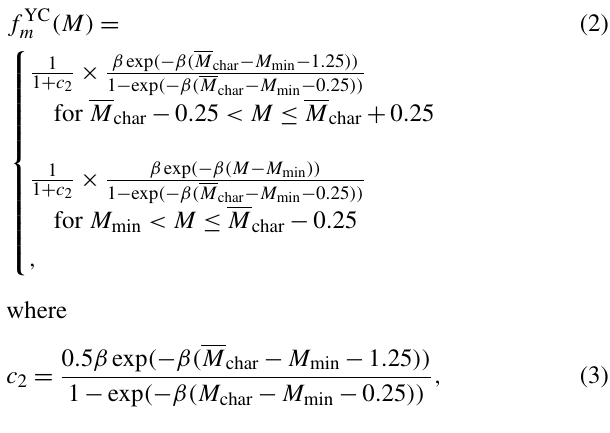
to unity. The truncated exponential MFD (Cosentino et